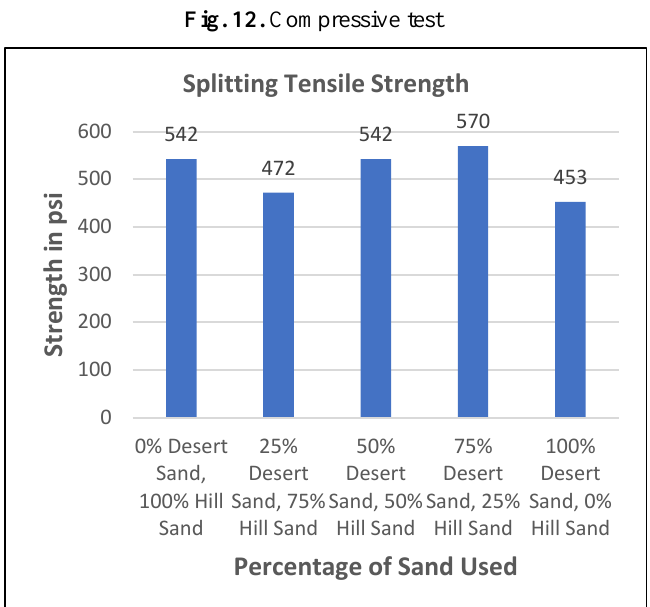
Fig.13. Splitting tensile test